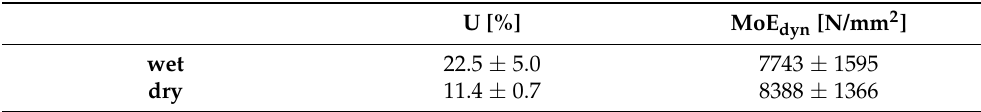
Table 3. MoE dyn average values in wet and dry